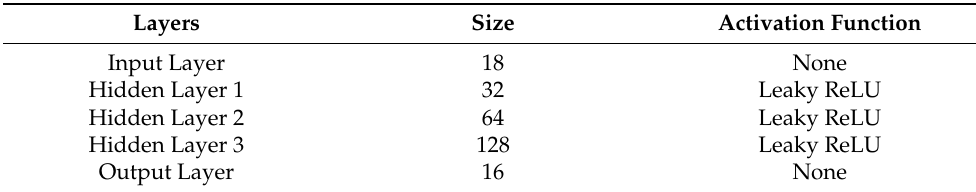
Table 2. Layer design of DQN neural